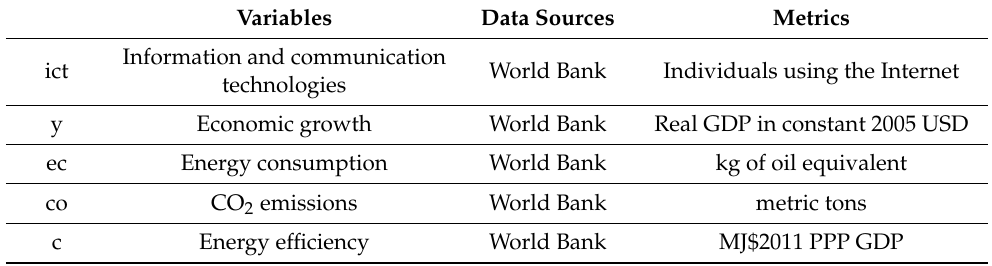
Table 2. Variables.